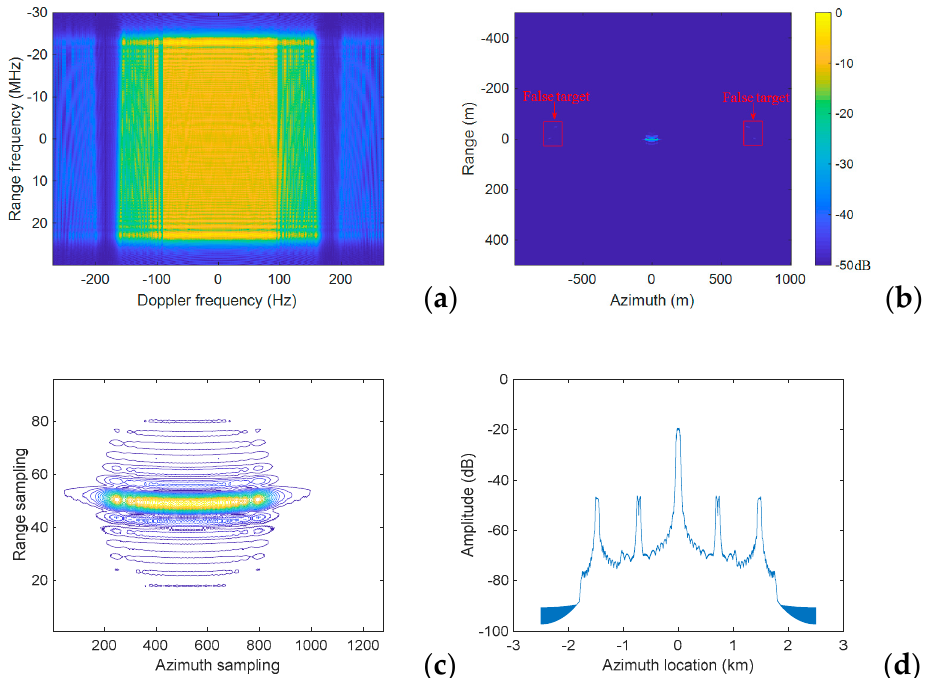
Figure 6. The focused moving target with the along track velocity of 10 m / s. ( a ) Reconstructed two-dimension spectrum. ( b ) The focused point target. ( c ) Contour plots of the point target. ( d ) The maximum azimuth projection profile.